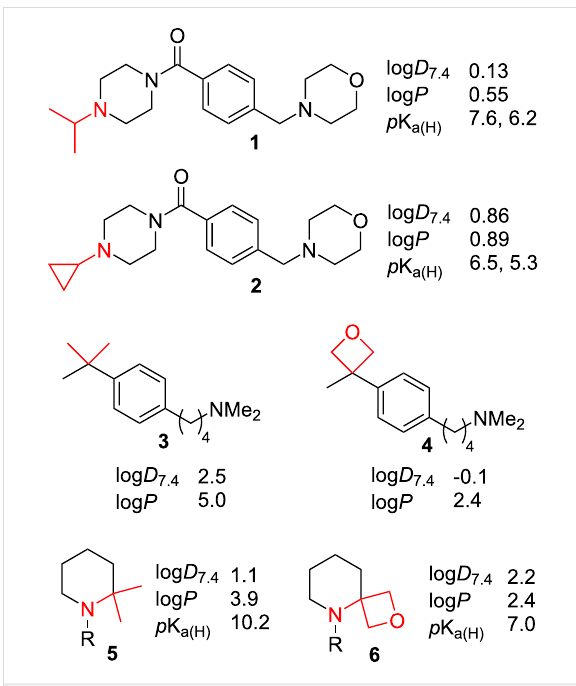
Figure 1: Examples of lipophilicity modulation for geminal dimethyl to cyclopropyl and oxetane modifications (measured experimentally via shake-flask method).